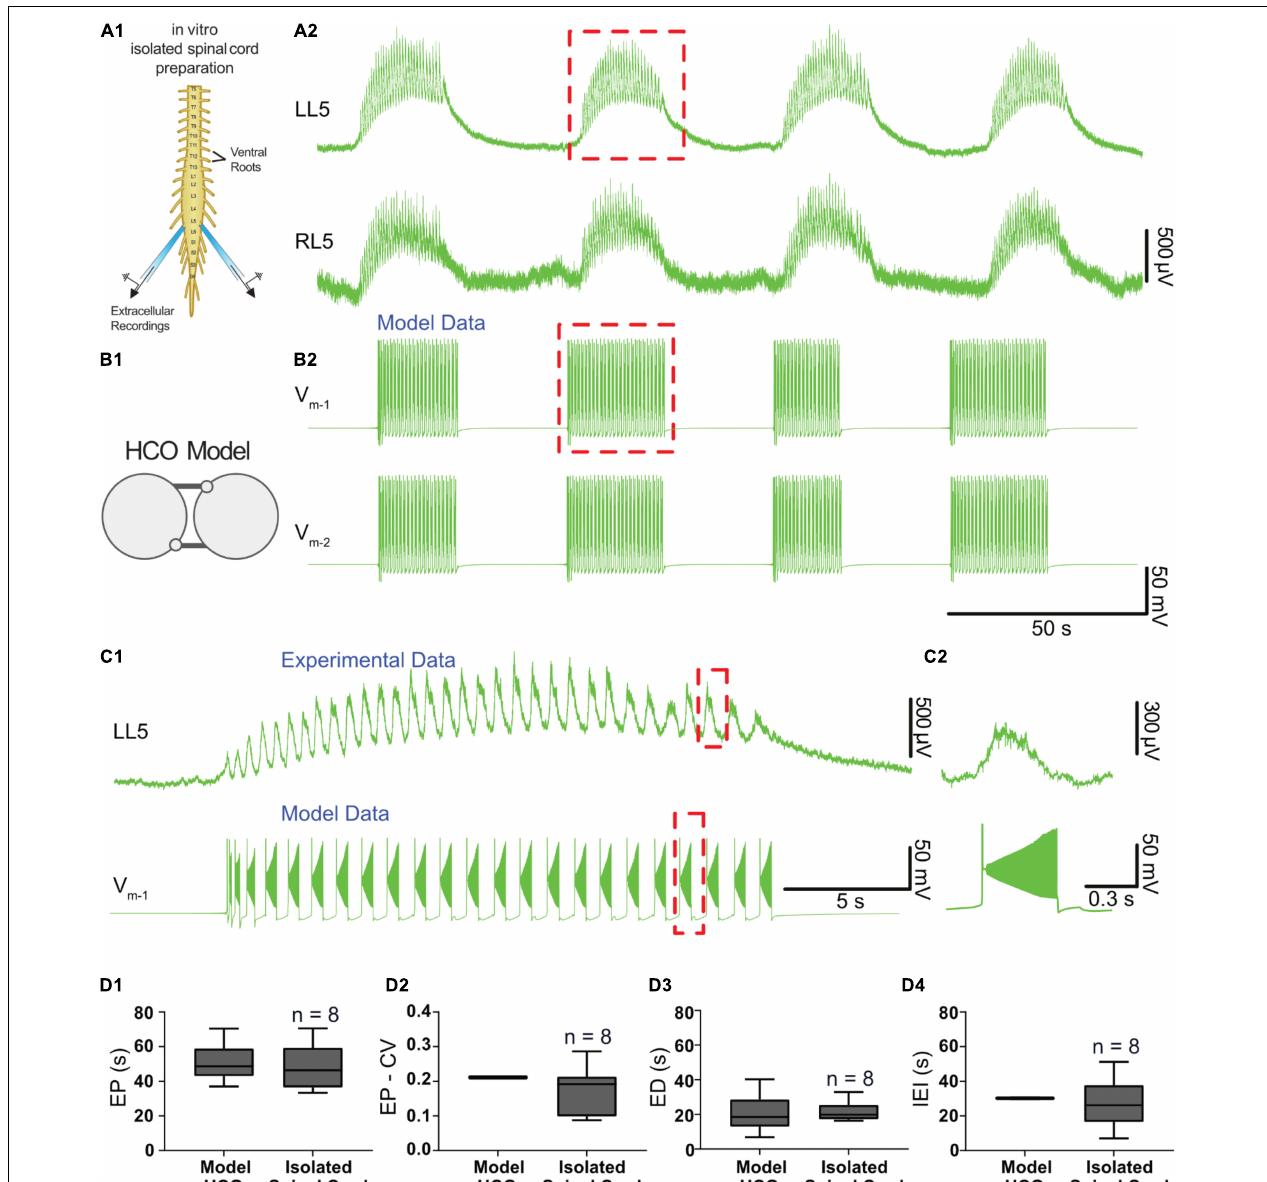
FIGURE 4 | Temporal characteristics of dopamine-evoked episodic rhythmicity in the isolated spinal cord, reproduced by a biophysical model. (A1) Schematic showing recording setup used to obtain extracellular neurograms from isolated neonatal mouse spinal cords. (A2) Episodes of rhythmic activity generated by isolated spinal cords with dopamine (50 µ M). Neurograms represent recordings from left and right L5 ventral roots. (B1) The half-center oscillator (HCO) model was tuned to produce episodic rhythmicity (B2) . (C1) Similar intra-episode rhythm features in a single episode of activity recorded experimentally (top trace) and from the model (lower trace) show bursting slowing down throughout the episode. (C2) The burst period and burst duration of a single intra-episode burst recorded experimentally (top trace) corresponds closely to a single burst within the model (lower trace), especially for the latter portion of the episode. (D1) Model-generated episodes (bottom trace) of activity match the recordings (top trace) in terms of episode period (EP). (D2) episode period variability (EP-CV), (D3) episode duration (ED), and (D4) interepisode interval (IEI). Box and whisker plots depict interquartile range (boxes), median (horizontal black lines), maximum, and minimum values in data range